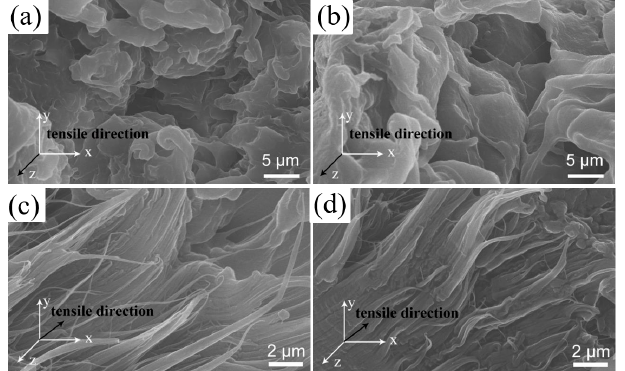
Figure 4. Surface micromorphology of samples: ( a – e ) as-spun filament samples of U, U/H, U/H/Si-0.5, U/H/Si-1.0 and UH/Si-2.0; ( f – j ) fiber samples of U, U/H, UH/Si-0.5, UH/Si-1.0 and UH/Si-2.0.